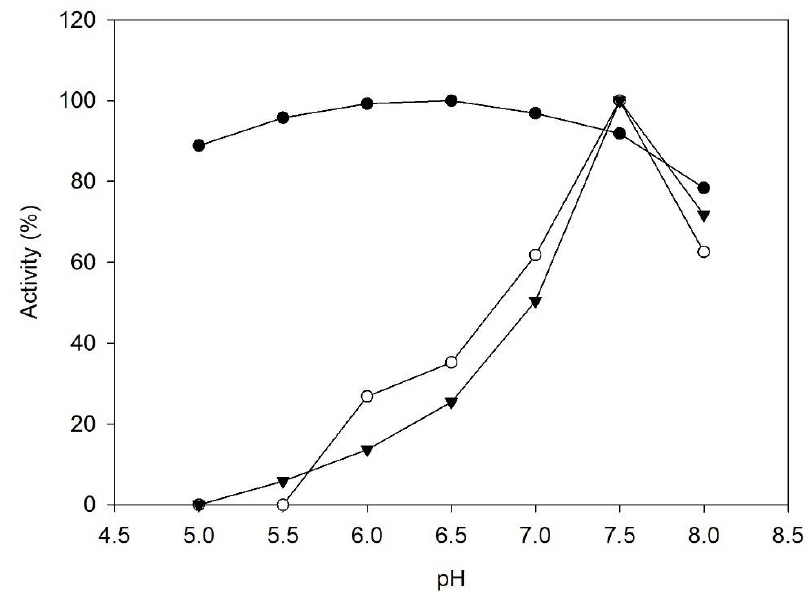
Figure 2. pH activity profile of PDC (●), Cvi-TA ( ○ ), and Vfl-TA ( ▼ ). Assays were performed with citrate buffer 100 mM (pH 5–6), potassium phosphate buffer 100 mM (pH 6.5–8).